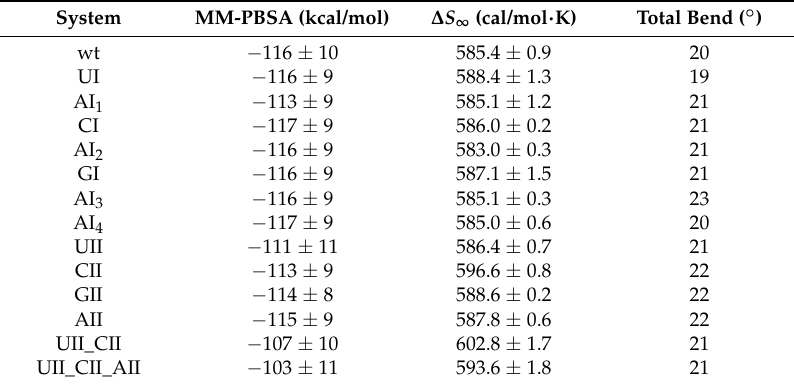
Table 2. Energy of formation of RNA duplexes, entropy contributions, and total bend.